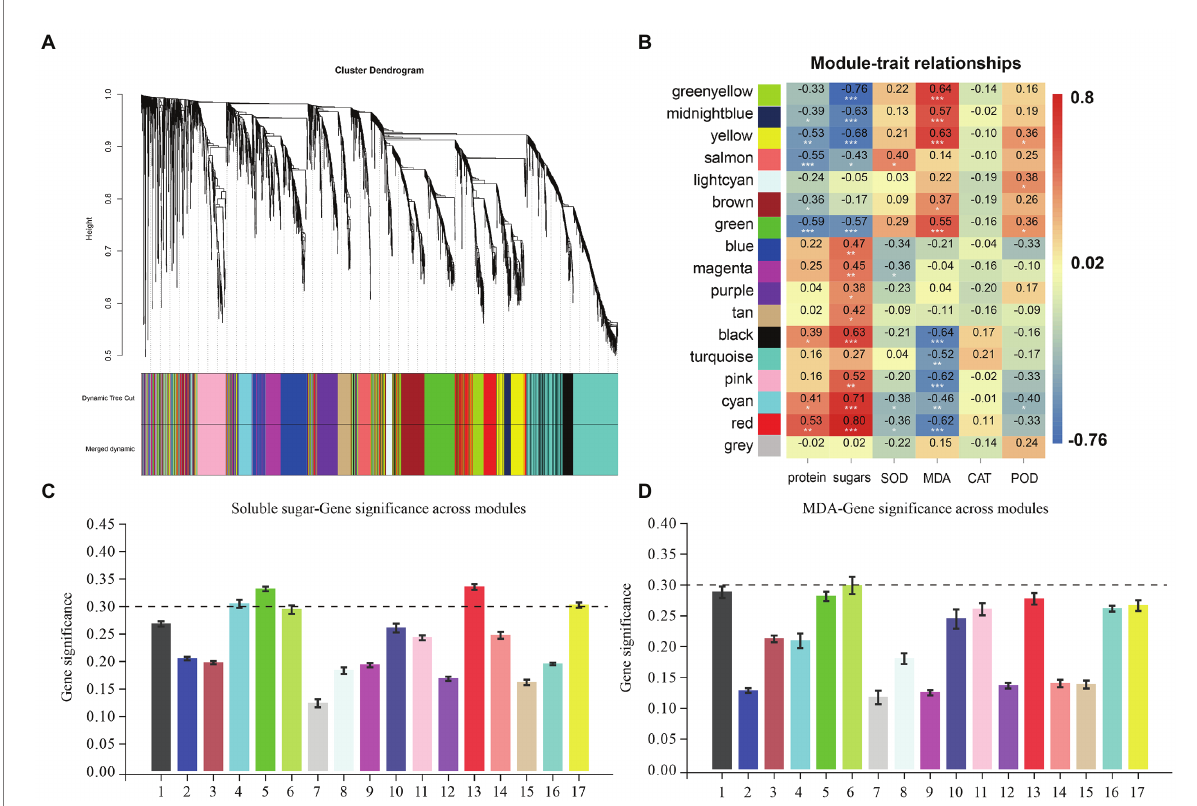
FIGURE 5 WGCNA coexpression network and module-trait correlation analyses. (A) The hierarchical cluster tree shows the coexpression modules identified by the dynamic tree cut method. Different modules are marked with different colors. Each leaf in the tree represents one gene. The main branches constitute 17 modules and are labeled with different colors. (B) Correlations between physiological indices and WGCNA modules. Each line corresponds to a module marked with the same color as in (A) . The column corresponds to the physiological index, and the color of each cell indicates the correlation coefficient between the module and the physiological index (the number in the cell represents the correlation coefficient, and the asterisk represents the p value). (C) Correlations between soluble sugar and WGCNA modules. (D) Correlations between MDA and WGCNA